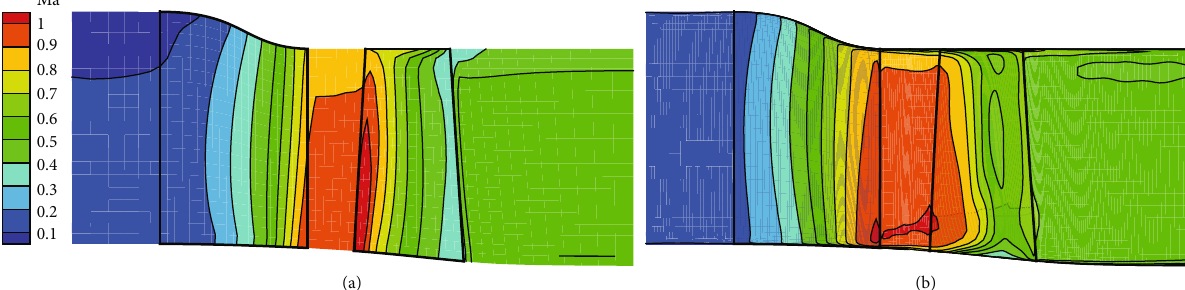
Figure 16: Absolute Mach number of the single-stage turbine: (a) Q3D; (b) 3D.